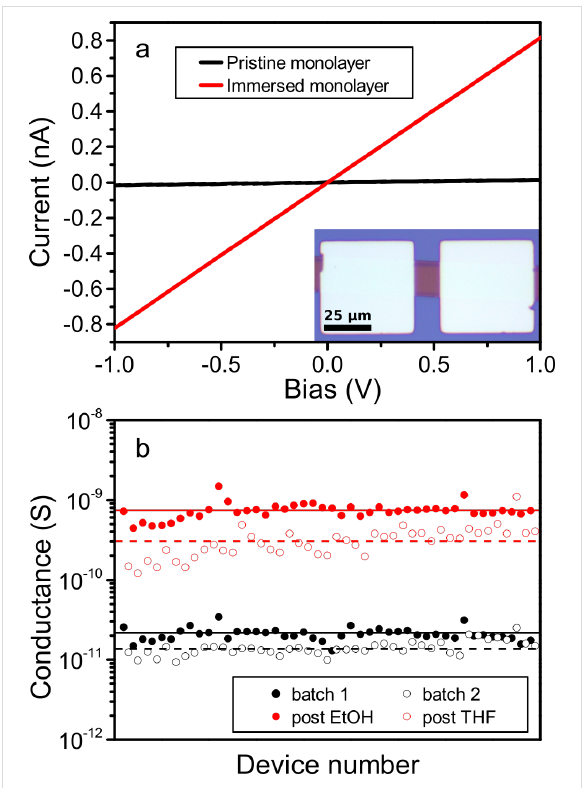
Figure 1: (a) Current–voltage relation of 20 µm × 10 µm gold nanopar- ticle monolayer before (black) and after (red) immersion in EtOH. The inset shows an optical image of a representative device. (b) Conduc- tance values measured for 44 devices and their mean values of two different batches before (black) and after (red) solvent immersion. Full and empty symbols represent measurements of devices of batch 1 and 2,